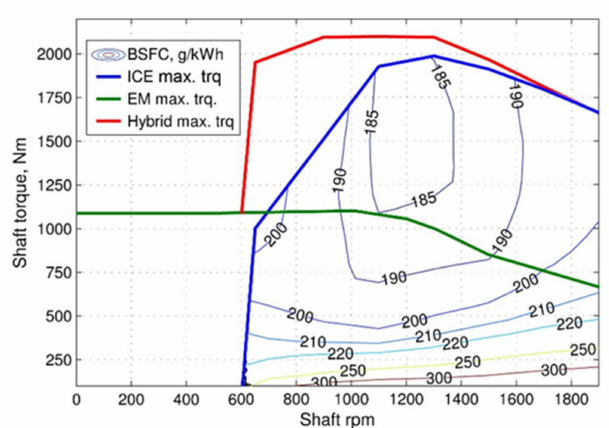
Figure 10. Superimposed torque characteristics of the hybrid unit and its